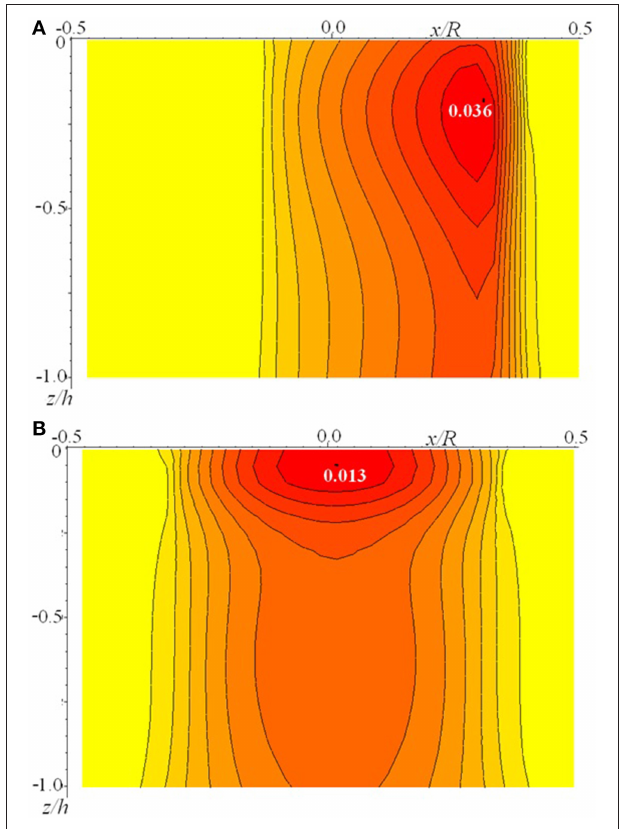
FIGURE 10 | Dependence of principal shear stresses on layer thickness [ V ∗ = 0.333; c = 5; ν = 0.3; Q ′ = 0.1; h ∗ = 0.033 (A) , h ∗ = 0.166 (B) ].